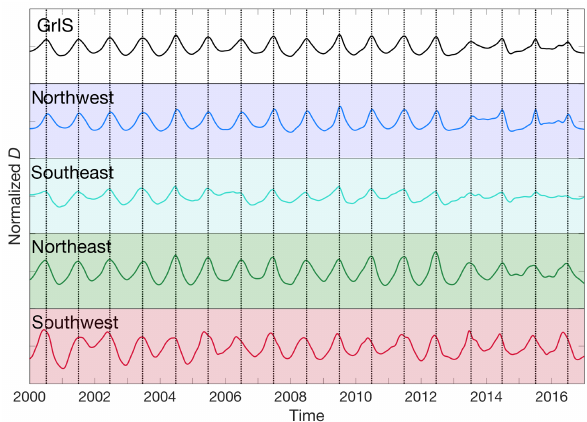
Figure 4. Normalized, detrended D time series for the total GrIS (top), NW (blue), SE (cyan), NE (green), and SW (red) regions. The normalized discharge within each panel spans from − 1 to 1. Vertical black lines align with the annual maximum D of the GrIS- wide